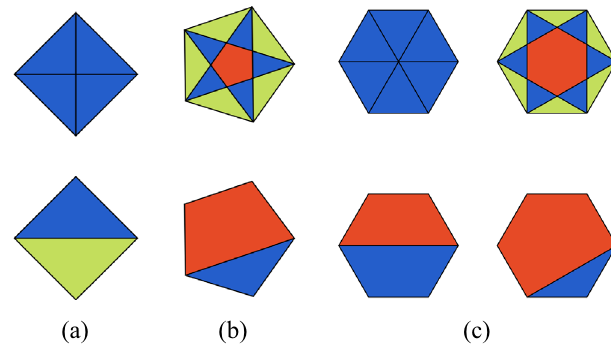
Figure 26. Cutting (a) square, (b) pentagon and (c) hexagon with diagonal